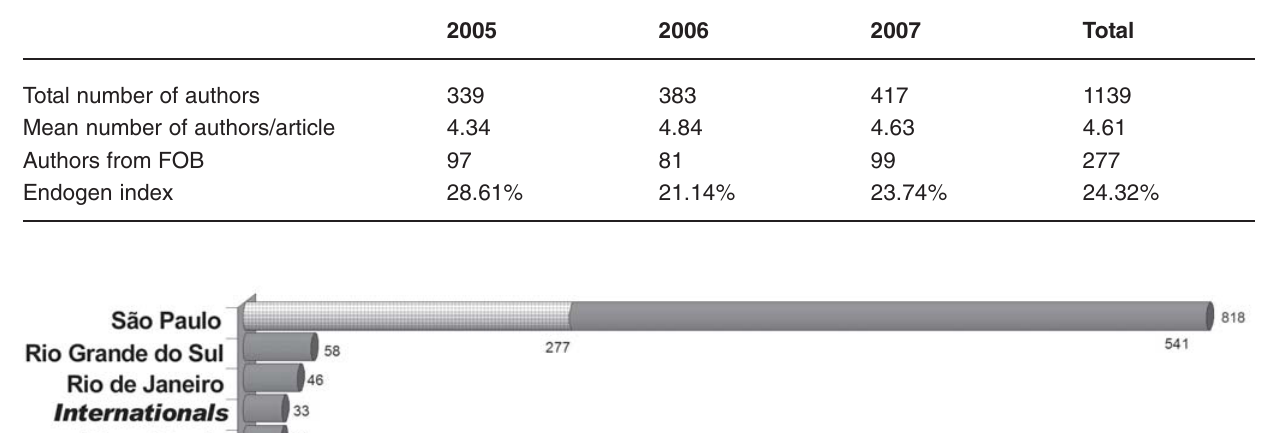
TABLE 3- Authorship and endogen index of the papers published in JAOS between 2005 and 2007